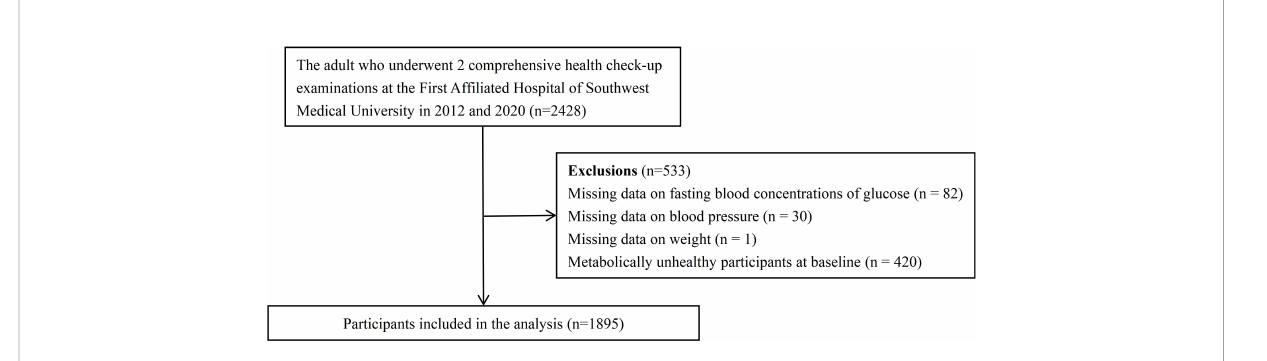
FIGURE 1 Flow chart of study participants.